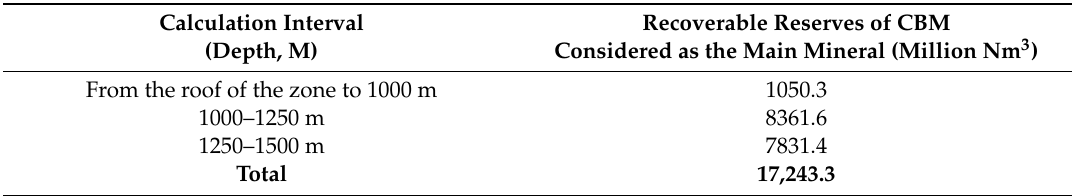
Table 5. Recoverable reserves of CBM considered as the main mineral in the first prospective region.